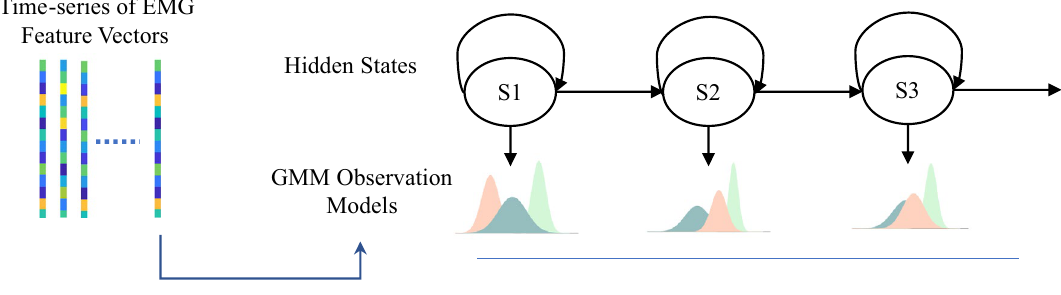
Figure 4. Diagram of a particular GMM-HMM for a sequence of sEMG feature vectors.